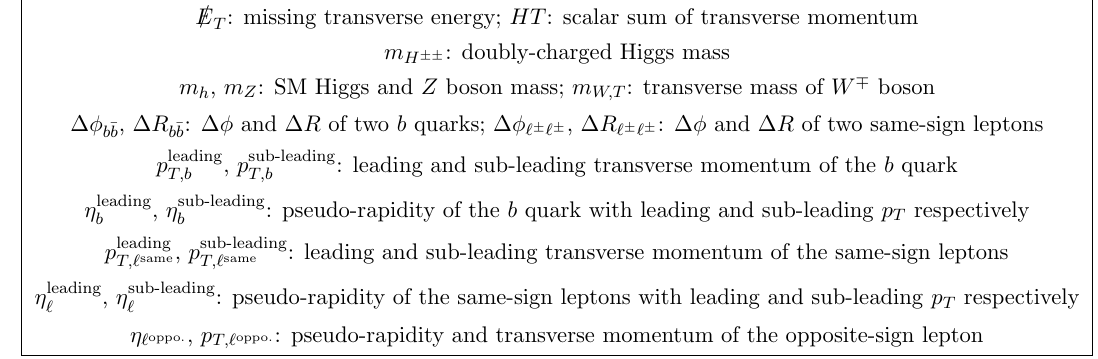
Table 4 . A list of BDT variables for W (cid:6) W (cid:6) hW (cid:7) , ‘ (cid:6) ‘ (cid:6) hW (cid:7) channels and their backgrounds. Since these two signals share the same backgrounds, we use the same BDT variables for both